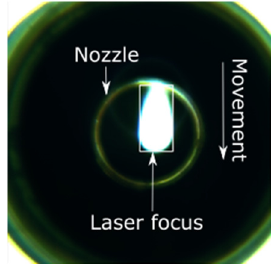
4 of 13 Figure 2. Top view of a metal sheet with a cut interruption ( top ) and complete cut ( bottom ). 2.2. Camera and Image Acquisition For image acquisition, we used a high-speed camera (Fastcam AX50, Photron, Tokyo, Japan) with a maximum frame rate of 170,000 frames per second. The maximum resolu- tion is 1024 × 1024 pixels, with a square pixel size of 20 × 20 µm 2 in combination with a Bayer CFA Color Matrix. For process image acquisition, videos of the laser cut process are grabbed, with a frame rate of 20 kilo frames per second with an exposure time of 2 µs and a resolution of 256 × 256 pixels. Even at this high frame rate, no oversampling occurs, and consecutive images are not similar, because the relevant underlying melt flow dynamics are very fast and vary at estimated frequencies between 100 kHz and 300 kHz [25]. This estimation is further confirmed by the typical melt flow velocity, which is in the range of 10 m/s [26], resulting in our sampling rate between two images in a melt displacement of 0.5 mm, which is significantly higher than our spatial resolution given by the camera’s specifications. Depending on the feed rate, each video consists of between 30,000 and 60,000 images. These videos also contain the acceleration and deceleration parts of the cut, i.e., the accel- eration and deceleration phases of the linear drives of the laser cutting systems. As cut interruptions only occur during the phase of a high feed rate, the images of the accelera- tion and deceleration paths are removed from the videos, resulting in 8000 to 40,000 im- ages per video. An example of such an image during a cut interruption is shown in Figure 3, revealing a large ring at the brinks that depicts the inner side of the cutting head, while the small ring in the middle reflects the nozzle. The top side of the cut kerf—and, there- fore, the laser focus—is indicated by a bright area inside the nozzle. The movement direc- tion in this image is downwards, so the tail behind the laser focus points upwards. To reduce the calculation time of the neural network from the image, a 32 × 64-pixel-sized image is extracted, which is indicated by the white rectangle in Figure 3 . The size on the